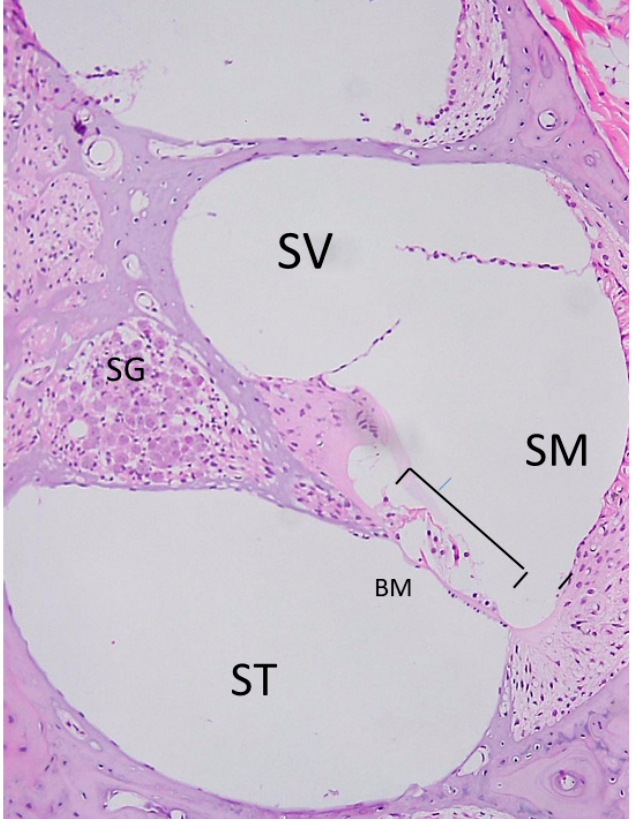
Figure 1. Photomicrographs of stained sections of the cochlea (hearing organ of the inner ear). Bracket delineates the organ of Corti, where hair cells and supporting cells (sensory epithelial cells) are located. The cochlea contains the scala media (SM), the scala tympani (ST), and the scala vestibuli (SV). SG, spiral ganglion; BM, basilar membrane.